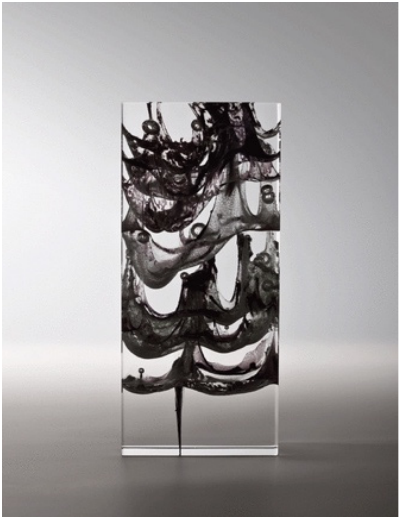
Figure 20. Sheila Labbatt, Ink Pot , 2012. Soda lime furnace glass, glass powders and solid flame worked inclusions and manipulate bubbles. Courtesy of the artist, used with